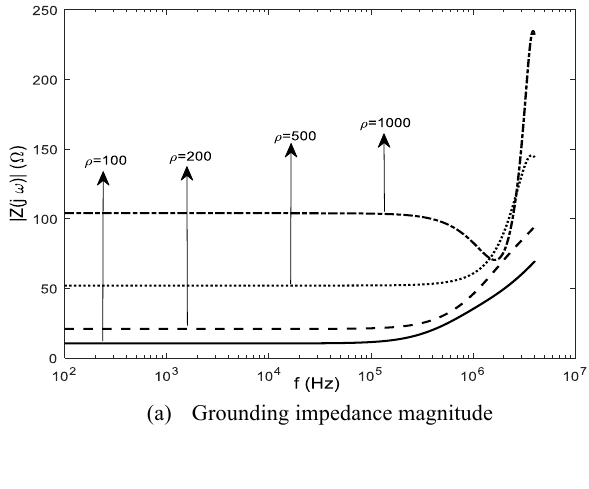
Figure 5: Variation of grounding impedance for different vertical electrode lengths (soil resistivity ρ =100 Ω .m and relative permittivity ε r =10) . In Fig. 6, the variation of grounding impedance for a vertical rod electrode with 7mm radius is shown for the soil with different resistivity.